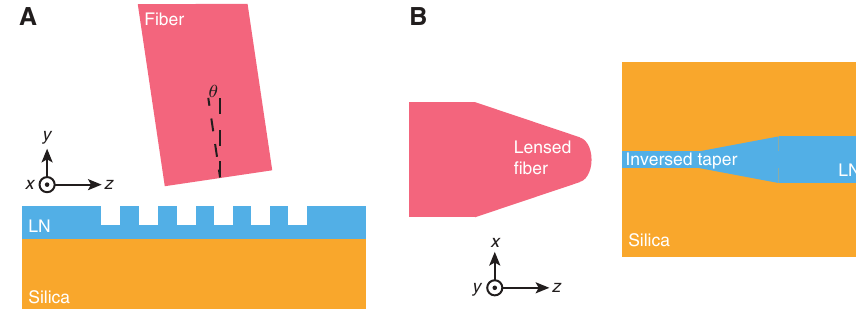
Figure 15: Schematic diagrams of optical coupling methods. (A) Grating coupling, (B) edge coupling. Light propagates in + z direction in the